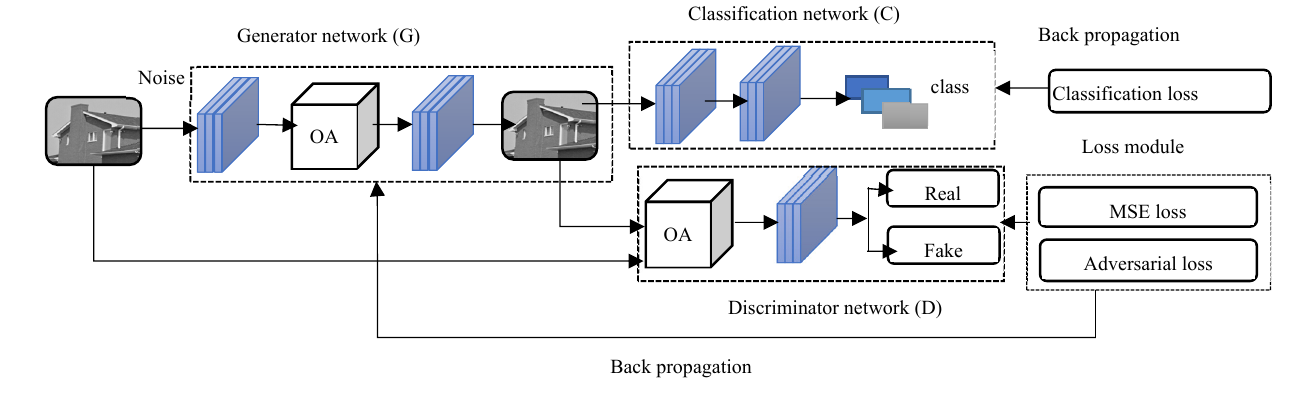
Figure 1. Whole network structure.